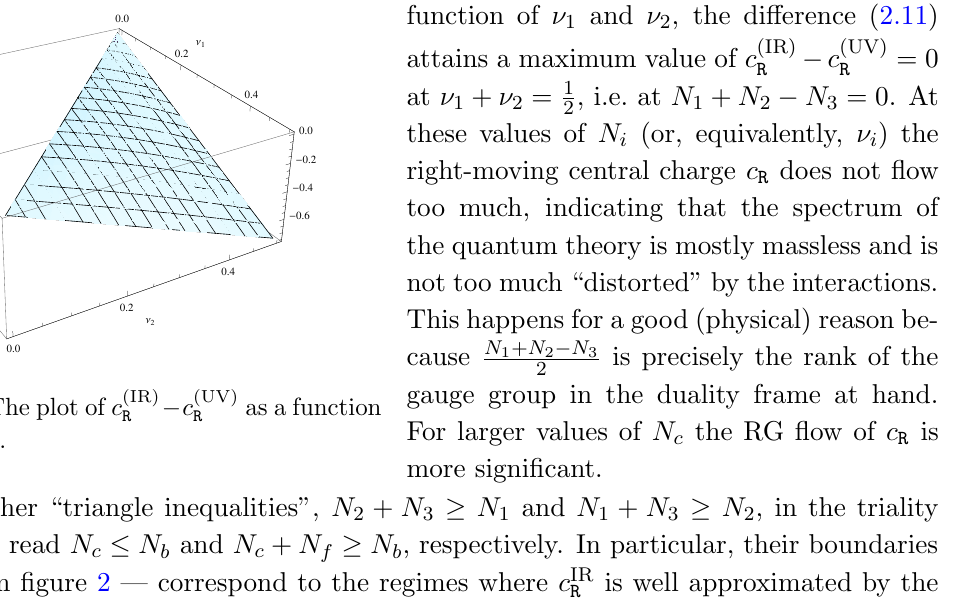
Figure 4 . The plot of c (IR) of (cid:23) 1 and (cid:23) 2